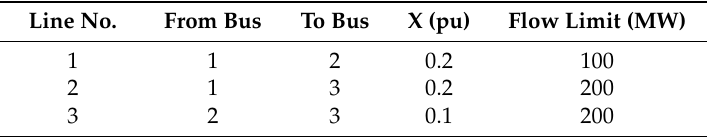
Table 2. Transmission lines data (reactance, capacity).